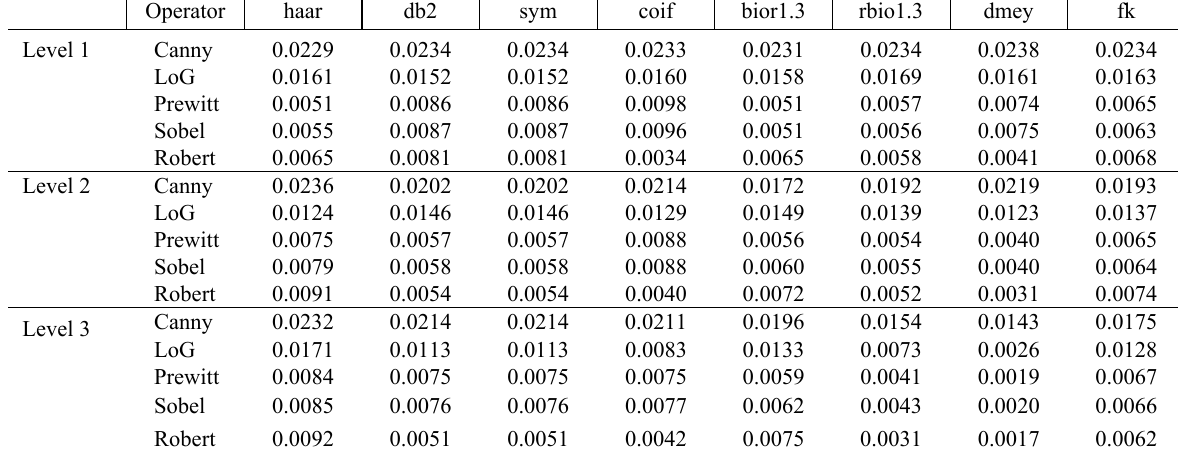
Table 10. F-measure values for different edge detection operators and wavelet transformations for an image with HD